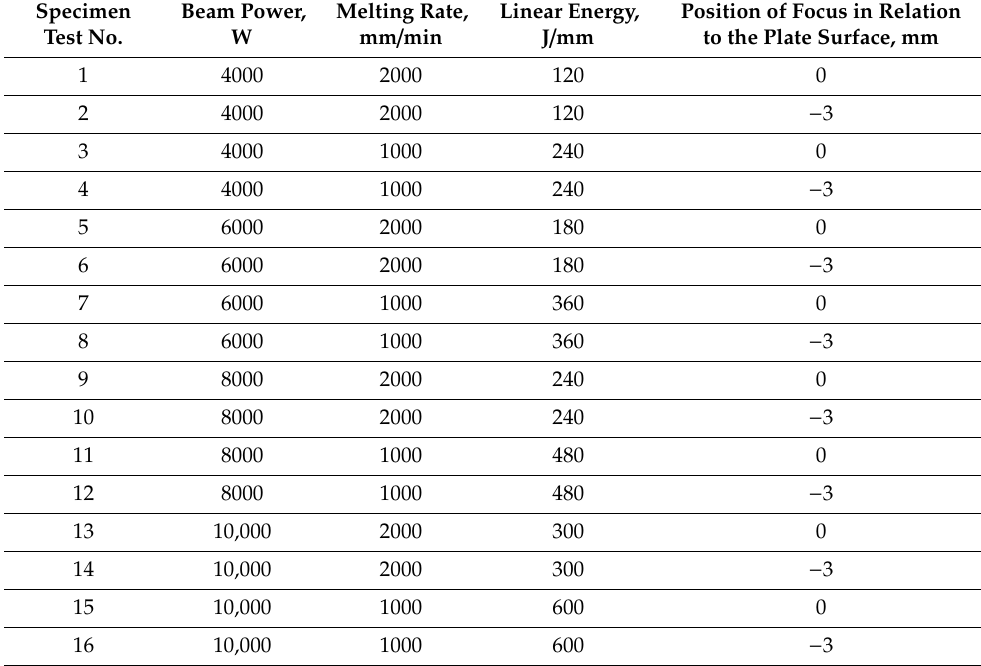
Table 2. Parameters of the remelting